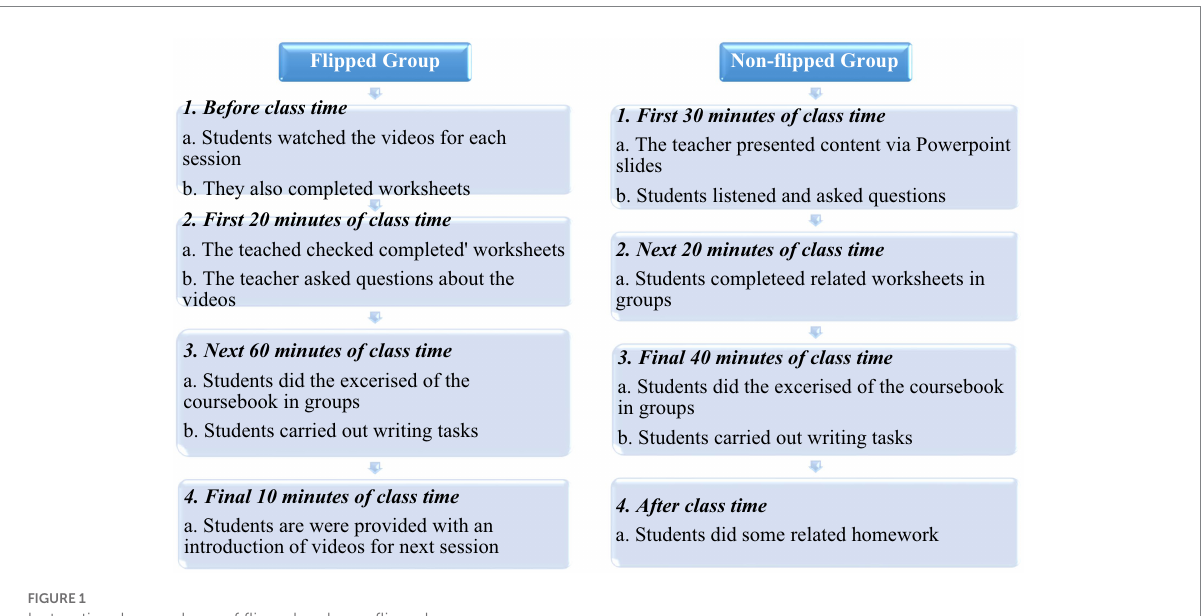
FIGURE 1 Instructional procedures of flipped and non-flipped